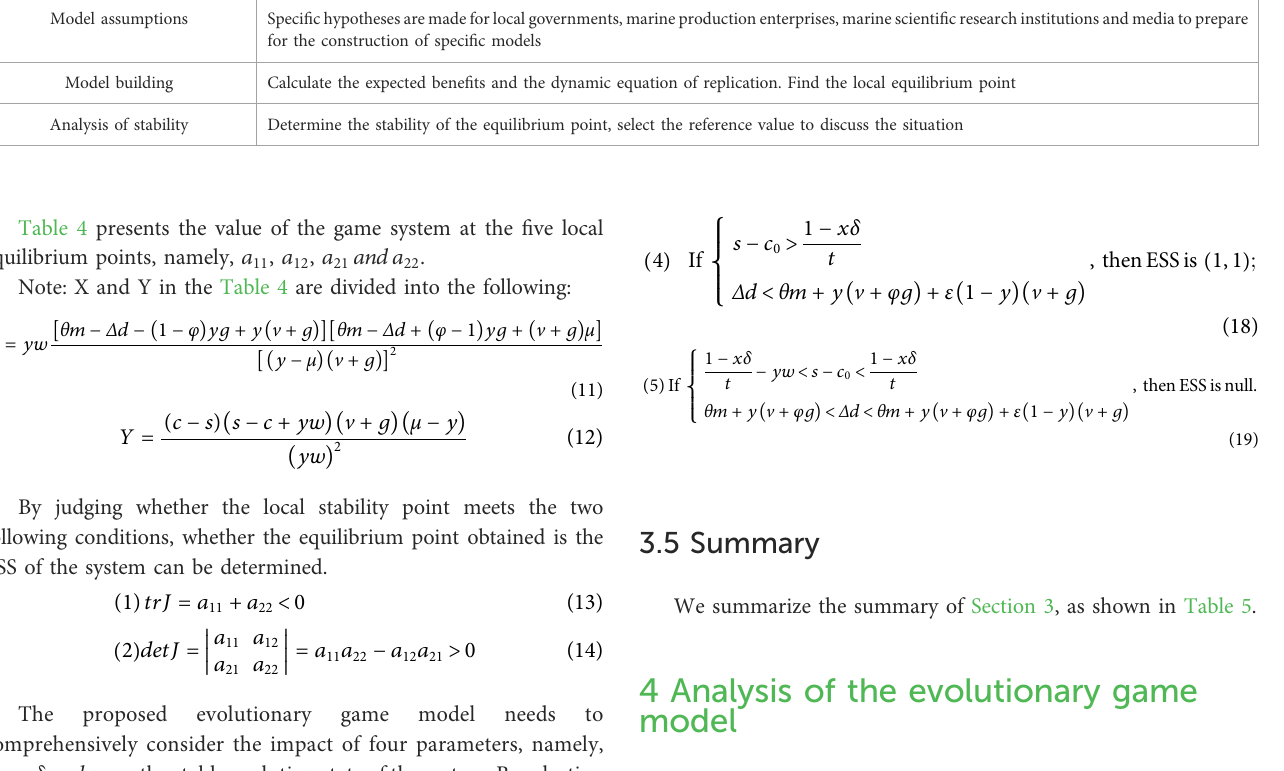
TABLE 5 Model summary. Subsections Commentary Parameter description Model assumptions